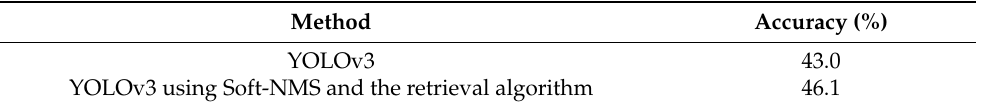
Table 2. The accuracy results of YOLOv3 improved using Soft-NMS and the retrieval algorithm. The test dataset was PASCAL